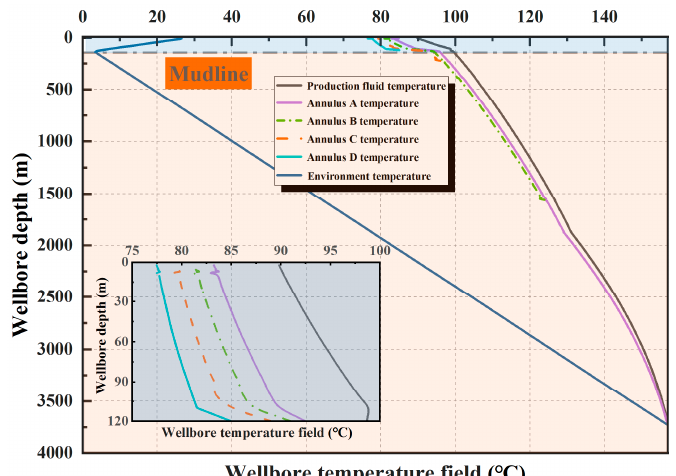
Figure 7. Wellbore temperature field.